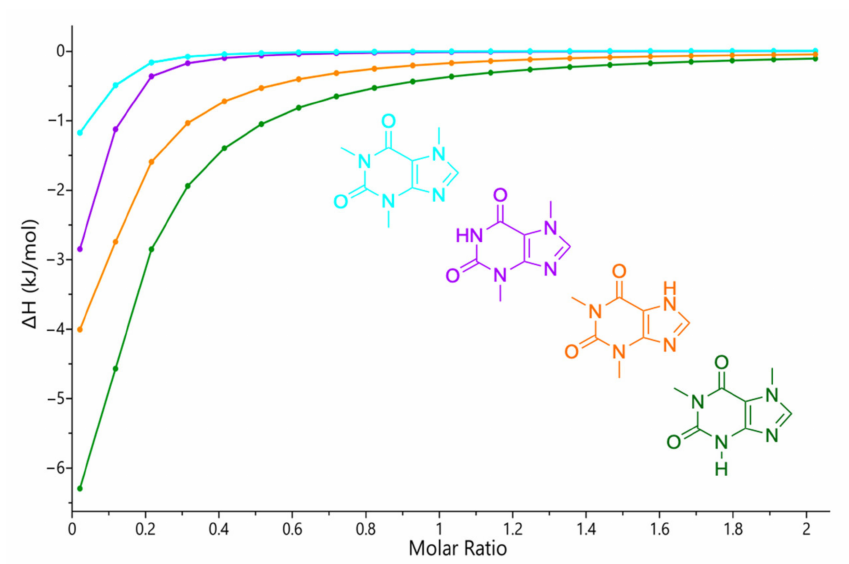
Figure 9. Integrated heat plots (enthalpograms) for the ITC titrations of 4-ethylimidazole (2.8 mM) with caffeine (28 mM, light blue ), theobromine (28 mM, purple ), theophylline (28 mM, orange ), and paraxanthine (28 mM, green ), at 25 ◦ C. All solutions were prepared in water.